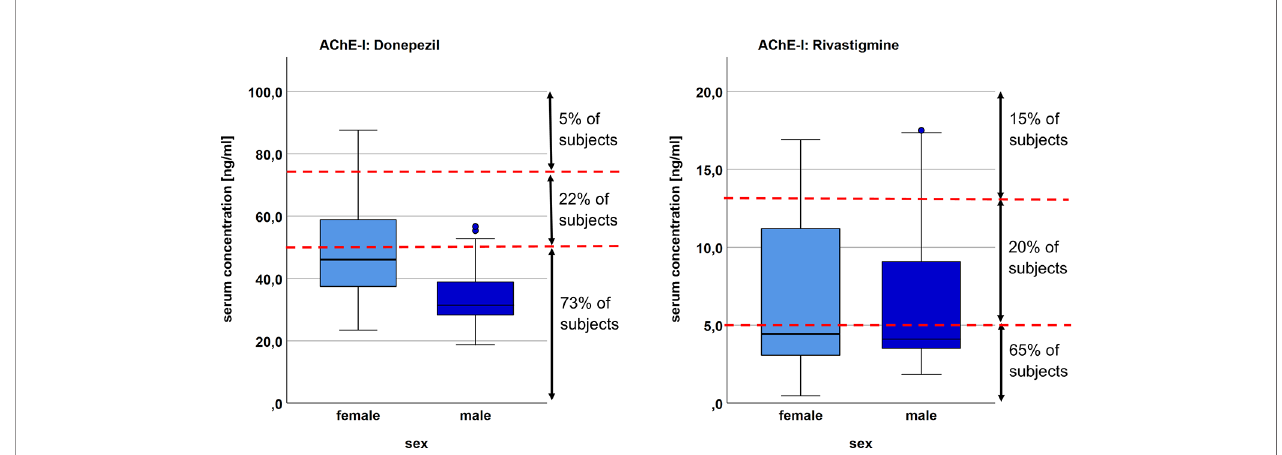
FIGURE 2 | Distribution of serum concentration for female and male subjects in the donepezil and rivastigmine group, respectively. Red dotted line marks the limits of the proposed therapeutic reference range (donepezil 50 – 75 ng/ml; rivastigmine 5-13 ng/ml (Hiemke et al.,